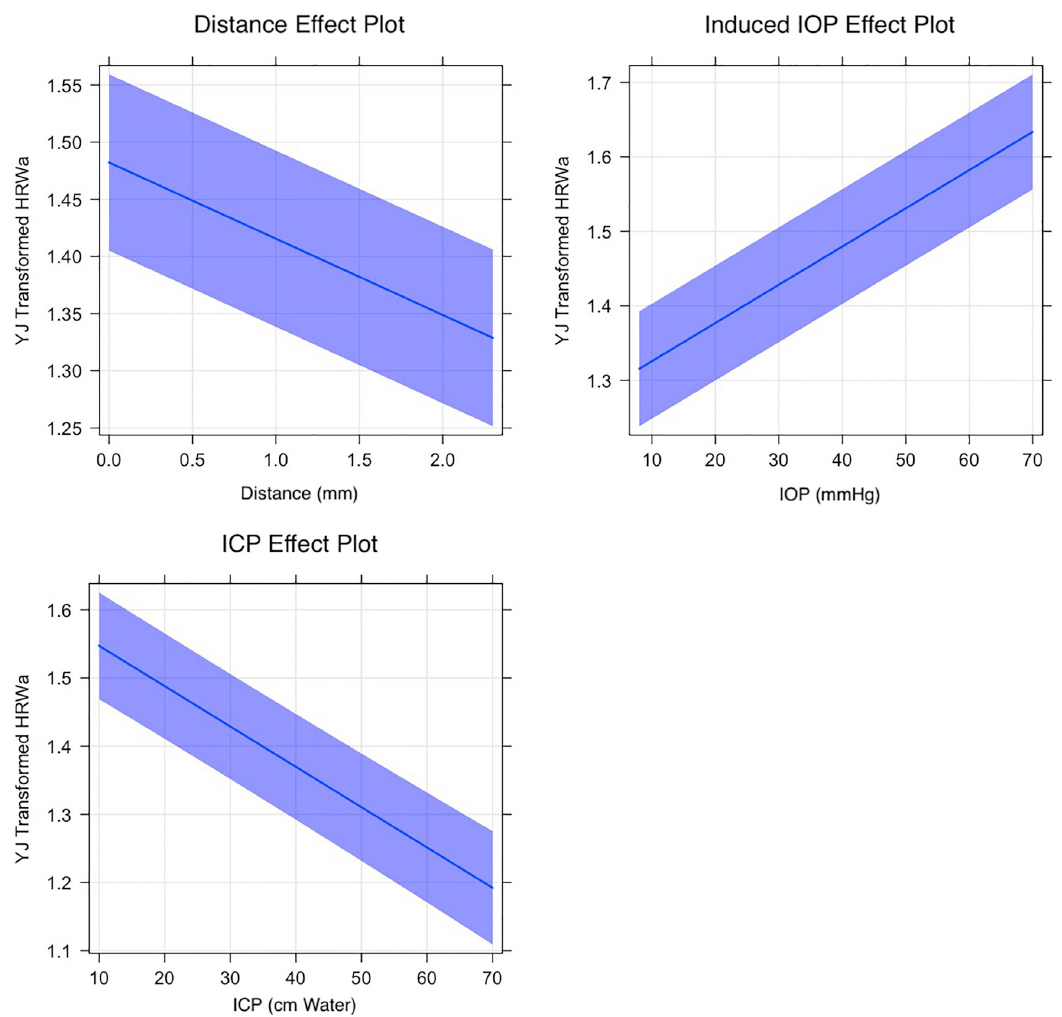
Fig 3. Effect plot of the retinal venous harmonic regression waveform amplitude (HRW a ). The slope of regression line correlating the HRW a with V Dist was -0.071 ± 0.002 whereas that correlating with ICP was -0.0059 ± 0.0004. There was amplification of the HRW a as indicated by a positive slope of regression with IOP i , was 0.0051 ± 0.00006 for all coefficients p-value <